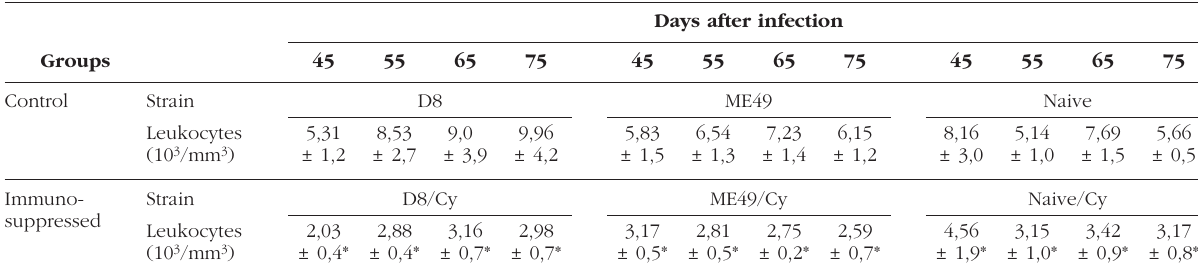
Table I. – Mean number and standard deviation of total circulating leukocytes (expressed in cells × 10 3 /mm 3 ) in the blood obtained 45, 55, 65 and 75 days after infection of BALB/c mice with the D8 or ME49 strains of Toxoplasma gondii